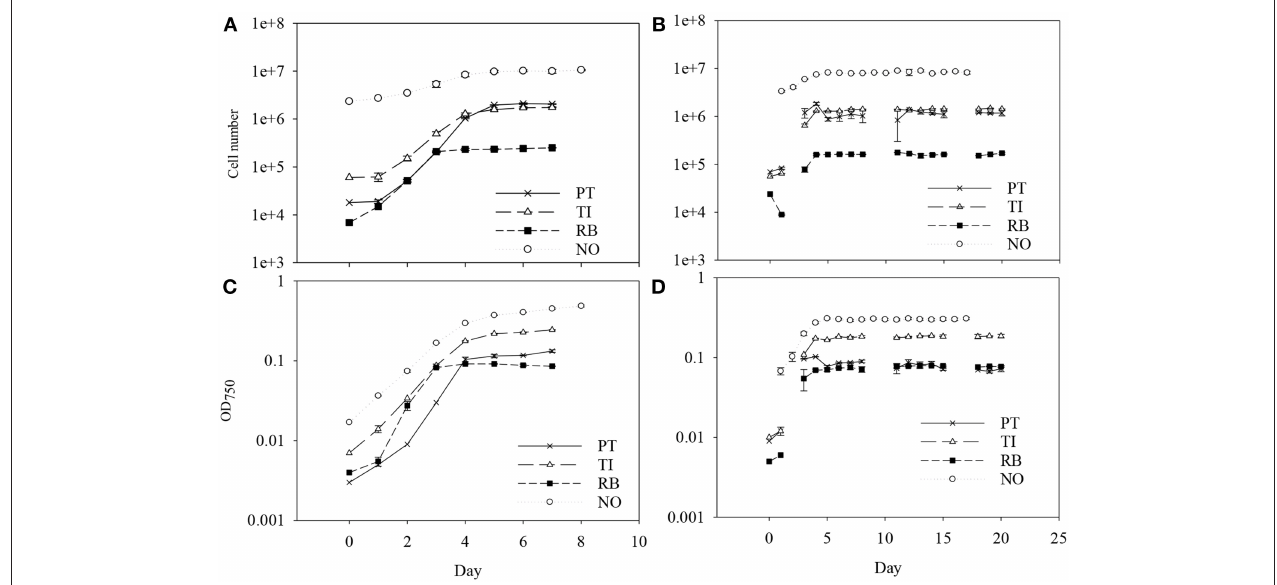
FIGURE 1 | The cell number and the optical density for batch culture (A,C) and for semicontinuous culture (B,D) of four marine microalgae species cultured under nitrogen limitation. Mean with SE bars. PT, P. tricornutum ; TI, Isochrysis aff. galbana clone T-Iso; RB, Rhodomonas baltica ; NO, N. oceanica .